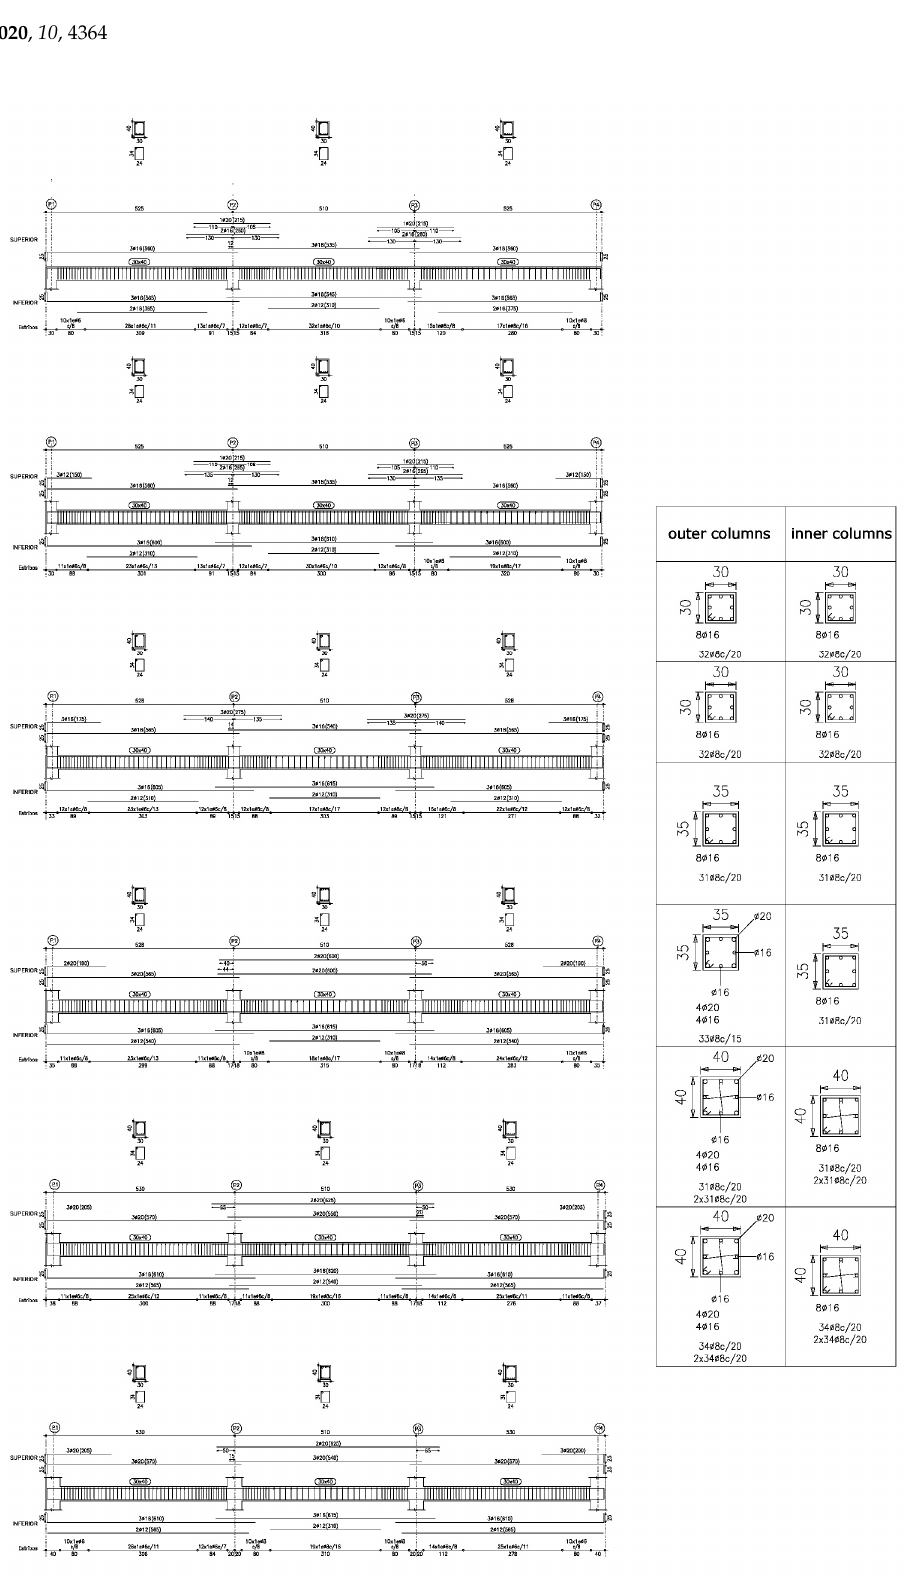
Figure A2. Dimensions and reinforcement for the 6-storey frames.